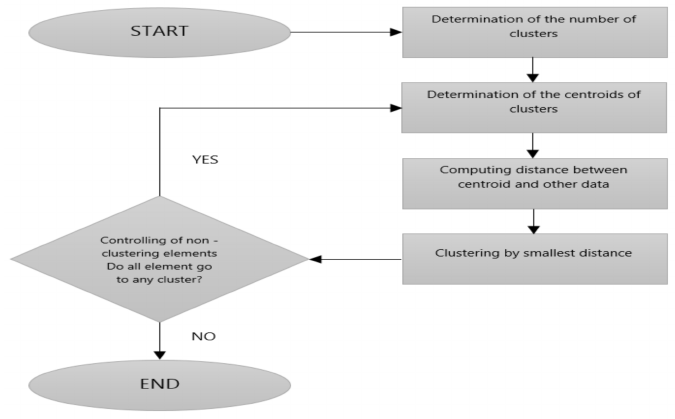
Figure 4. Flow diagram of the K-means (KM)